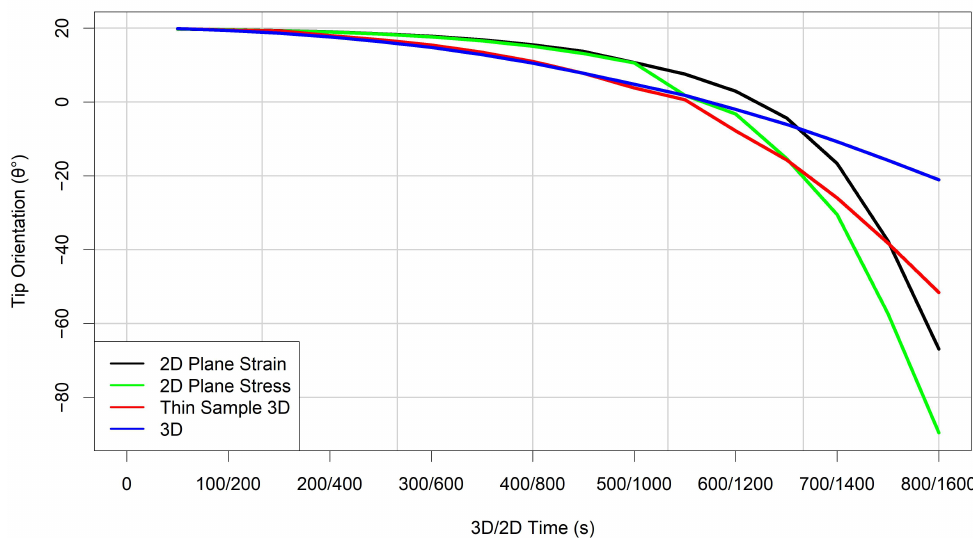
Figure 7. Orientation observed at the tip of dendrites grown using different modelling assumptions. Different time scales are used for 3D/2D comparison as the constrained diffusion in 2D approximately halves the growth